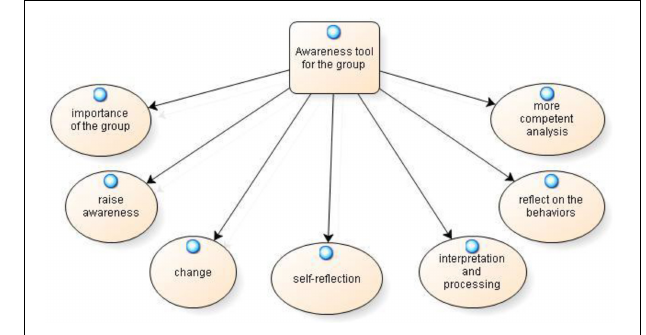
FIGURE 1 | Categories of individual and group reflective practices.